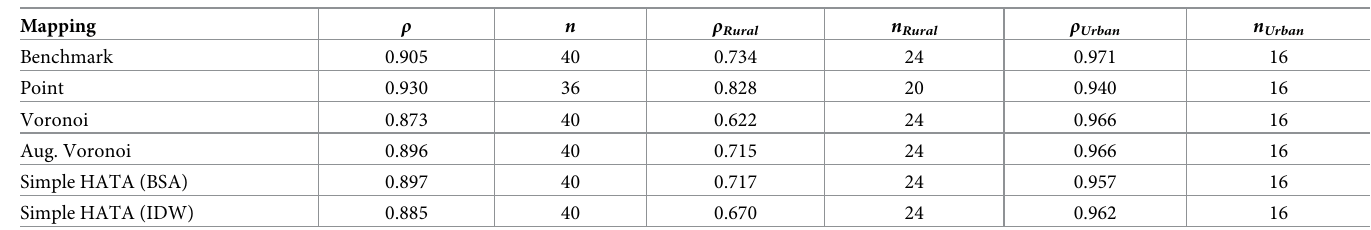
Table 5. Area-level correlation of estimated and true poverty rate & sample